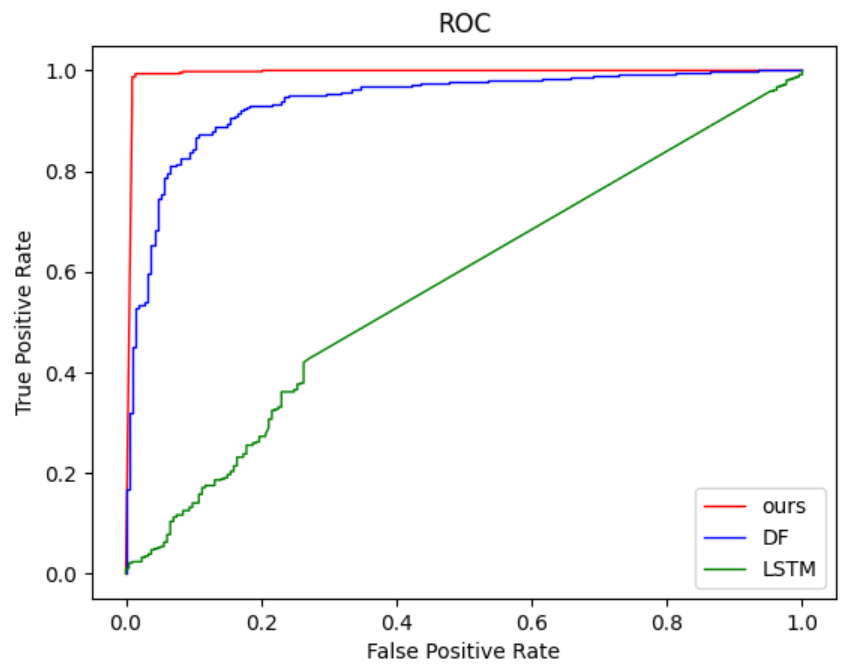
Figure 15. ROC on different models in the open-world setting.